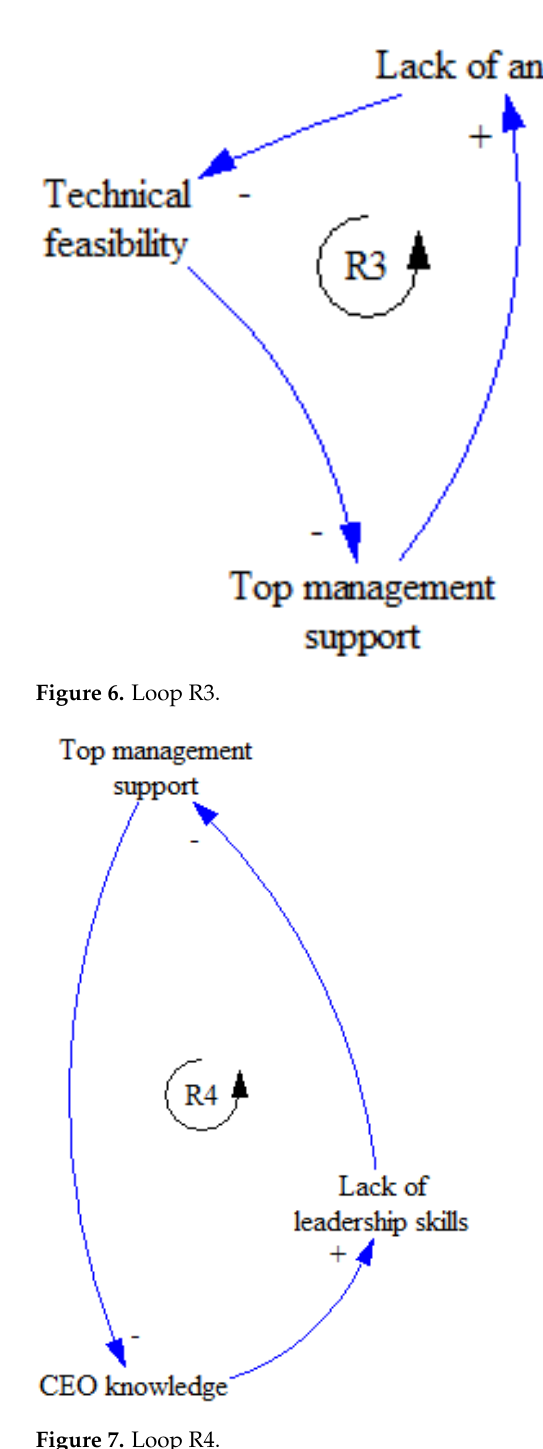
Figure 8. Loop B1. 4.1.6. Balancing Loop B2 The loop (B2), as evident from Figure 9, indicates that ‘Lack of information availabil- ity’ decreases trust and cooperation and increases complexity in projects. This leads to a corresponding increase in security issues and a lack of information availability. Hence, the availability of information is necessary to resolve all issues in CSCs. Figure 9. Loop B2.